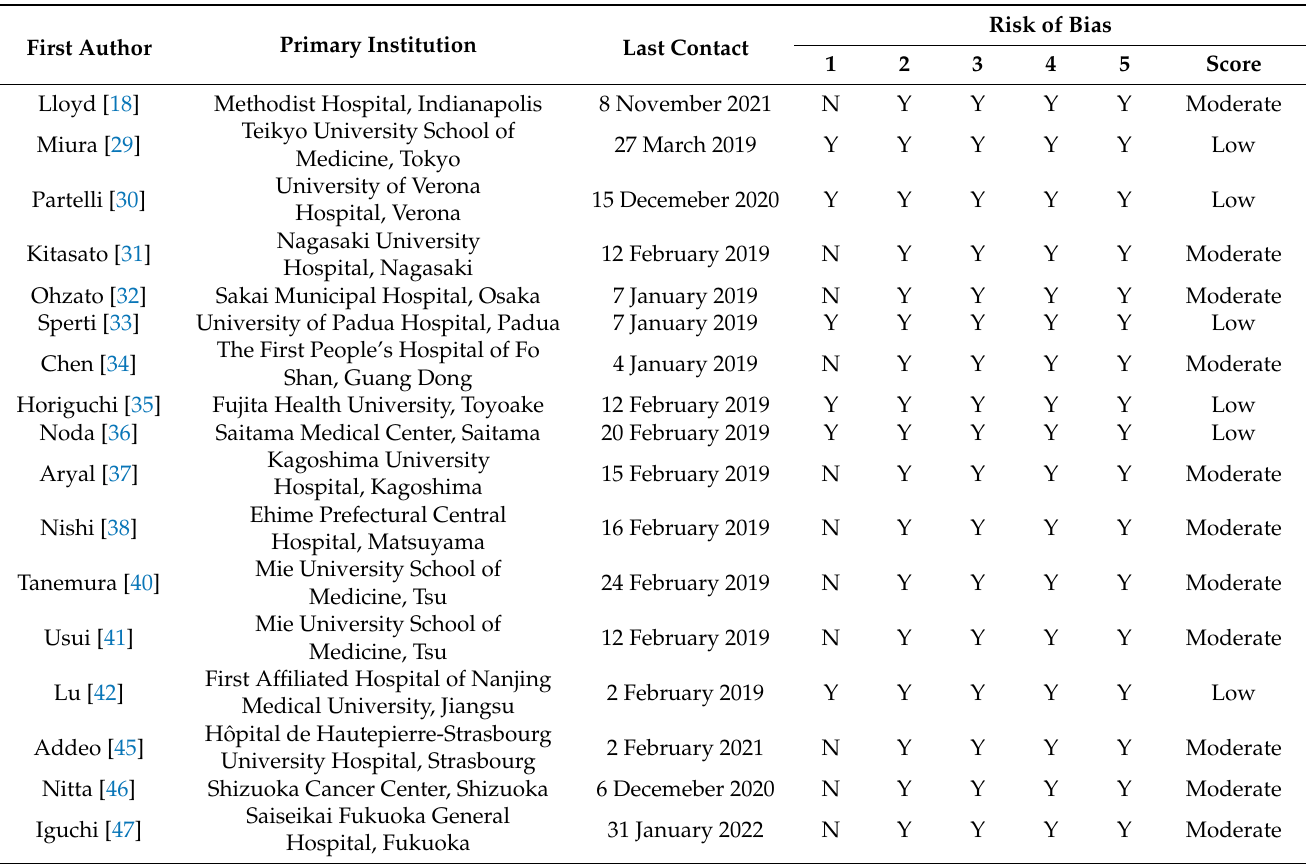
Table A1. Source publications for individual patient data, with the name of primary institution, date of last contact, and risk of bias assessed according to the criteria of Murad et al. 2018 [24]. (1) Selection: Do(es) the patient(s) represent(s) the whole experience of the investigator (center) or is the selection method unclear to the extent that other patients with similar presentation may not have been reported? (2) Ascertainment: Was the outcome adequately ascertained? (3) Causality (Outcome): Were other alternative causes that may explain the observation ruled out? (4) Causality (Follow-up): Was follow-up long enough for outcomes to occur? (5) Reporting: Is the case(s) described with sufficient details to allow other investigators to replicate the research or to allow practitioners make inferences related to their own